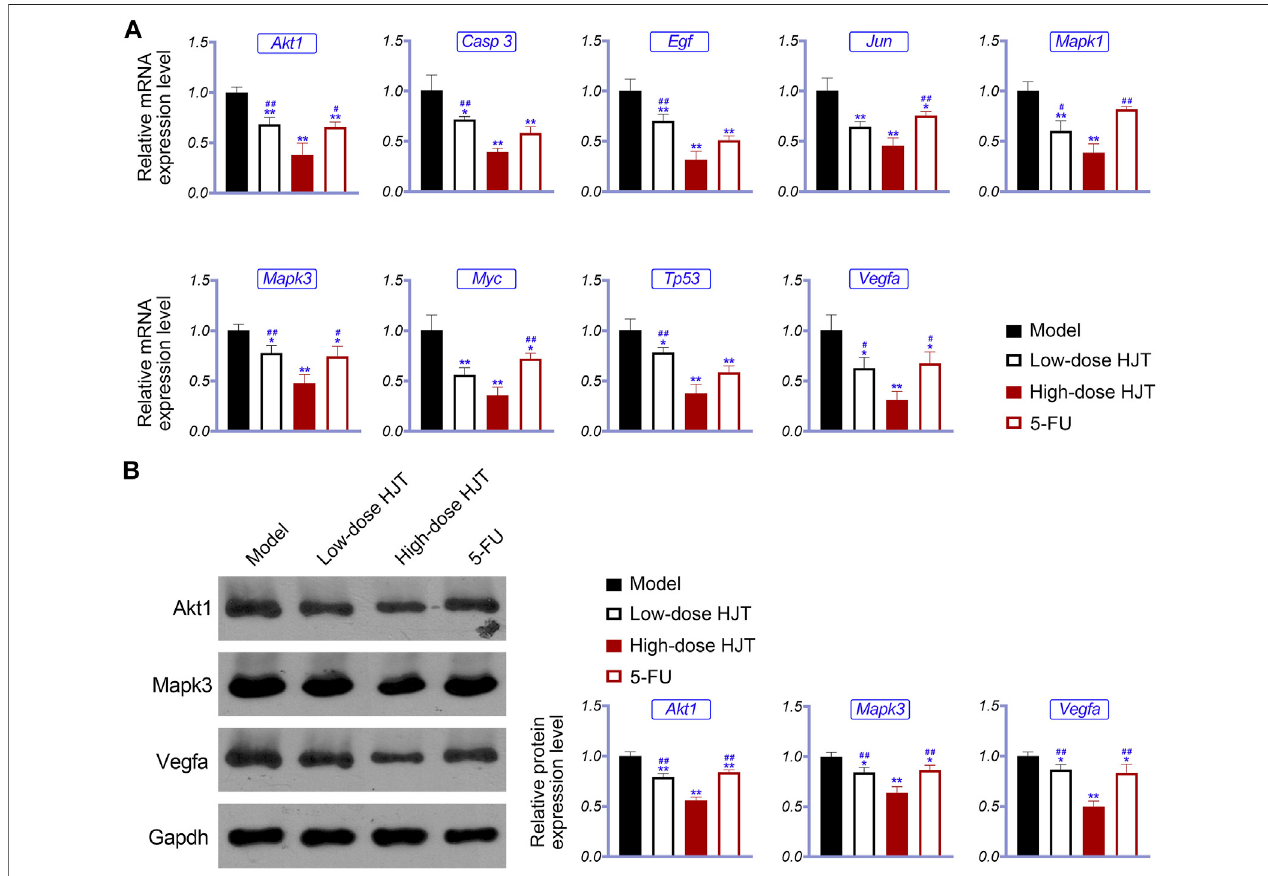
FIGURE 7 | Expression of hub genes in the tumor tissue of the control, low-dose HJT (0.66 g/ml gavage), high-dose HJT (1.32 g/ml gavage), and positive control (5-FU,20 mg/kgip.) groups. qRT-PCR wasused todetermine the relative mRNAexpression ofAkt1, Casp3, Egf,Jun, Mapk1, Mapk3, Myc, Tp53, and Vegfa (A) ,while western blotting was carried out to detect the relative protein expression of Akt1, Mapk3, and Vegfa (B) .